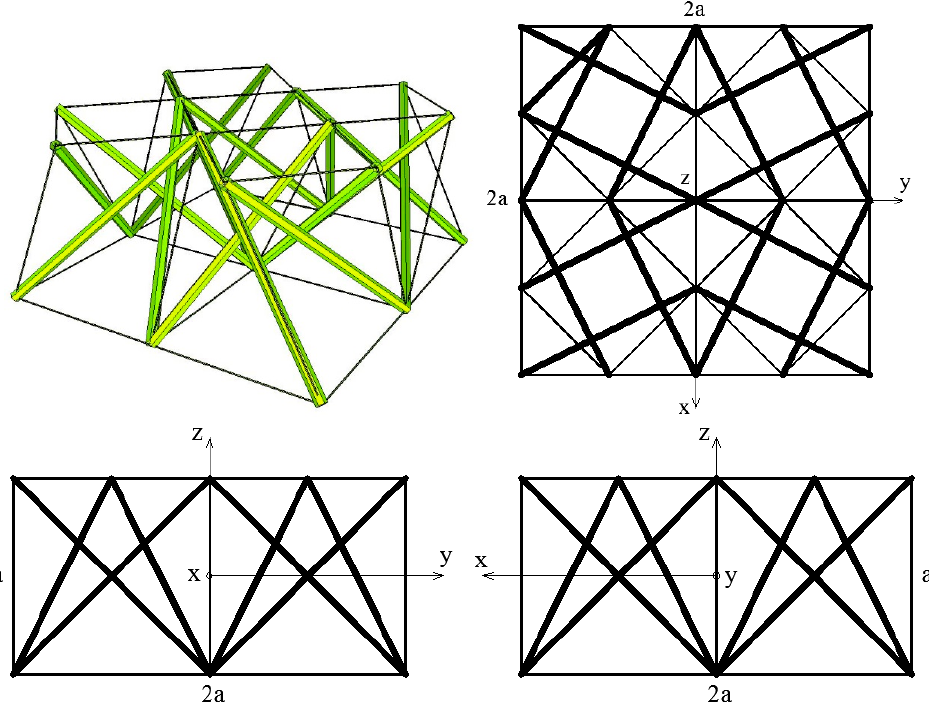
Figure 3. Geometry of a four-module layer—axonometry and three views.